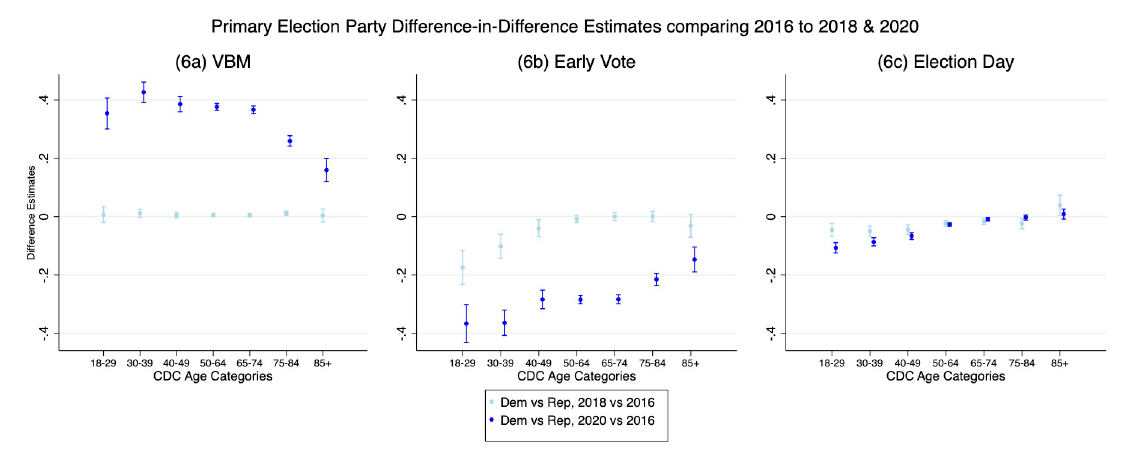
Fig 6. a-c. Primary election party